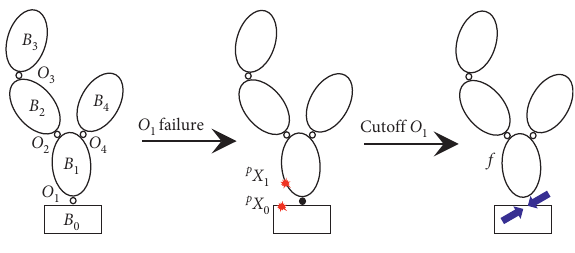
Figure 1: The stable impact motion